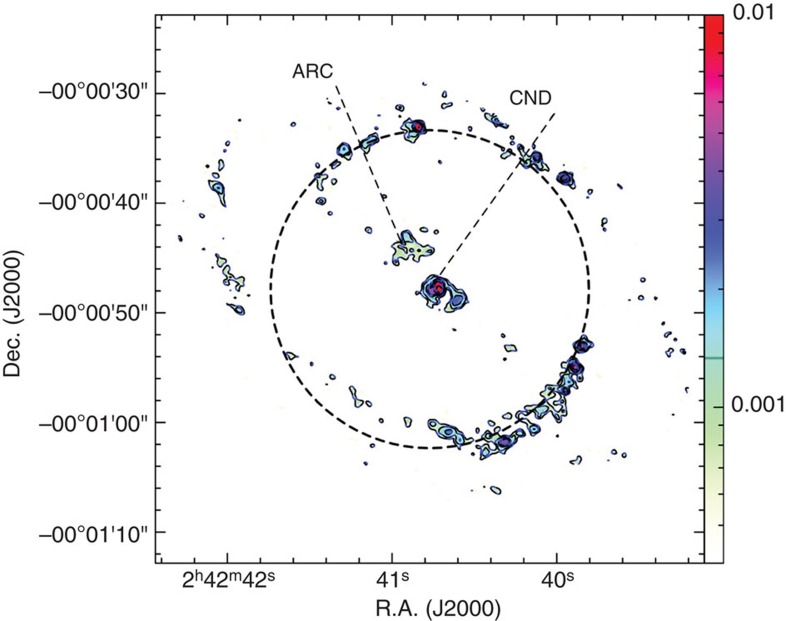
Sub-millimetre dust emission in NGC 1068.Three hundred and forty-nine gigahertz dust continuum emission from ALMA observation16. The ‘CND’ is circumnuclear disk and ‘ARC’ is a ‘bow-shock’ arc defined by 349 GHz dust emission obtained by ALMA observation16. The dashed circle shows the beam of IRAM 30-m, while the colour scale is for the flux in the unit of Jy per beam shown with the colour bar in the right.